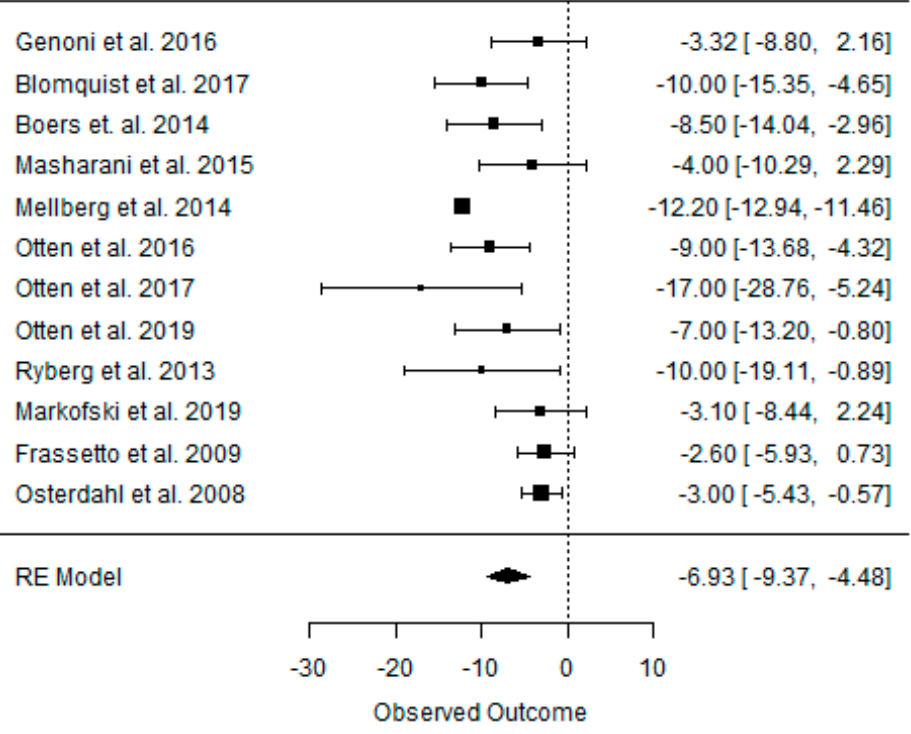
Figure A33. Forest plot of the effect of a CD on LDL-C in the long term (weighted mean difference).